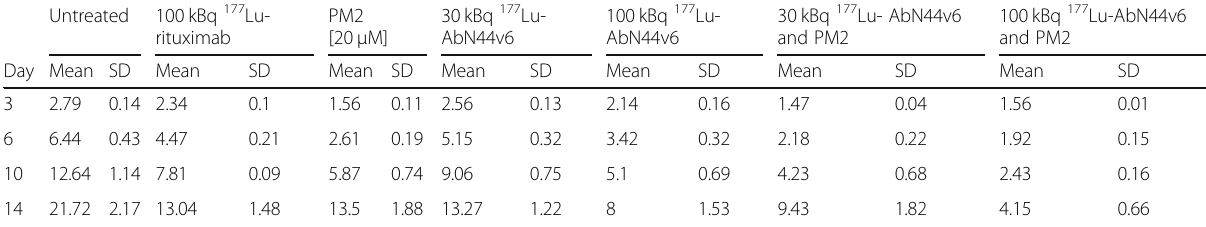
Table 1 HCT116 spheroid growth over time in mean and SD. n ≥ 4